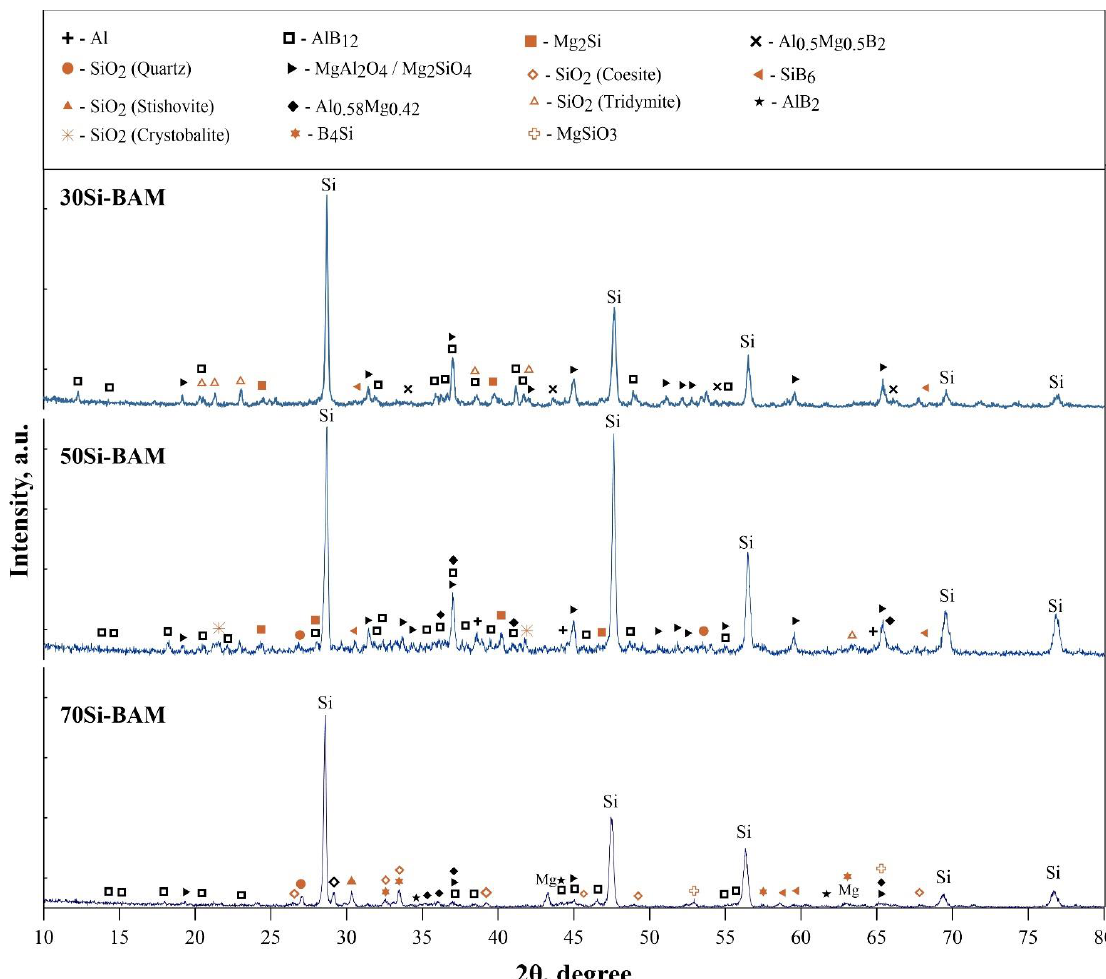
Figure 4. XRD pattern of the obtained specimens.